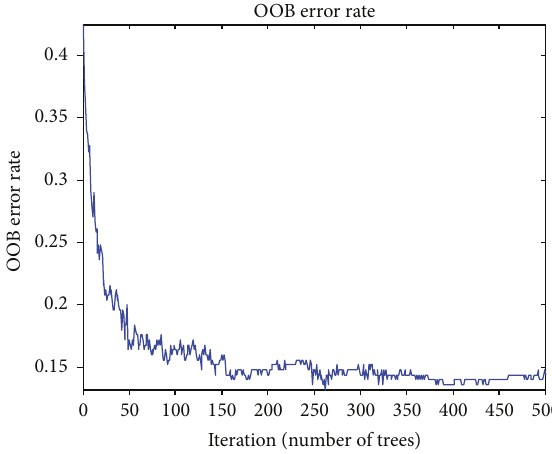
Figure 13: Fault diagnosis results after eliminating redundant information.